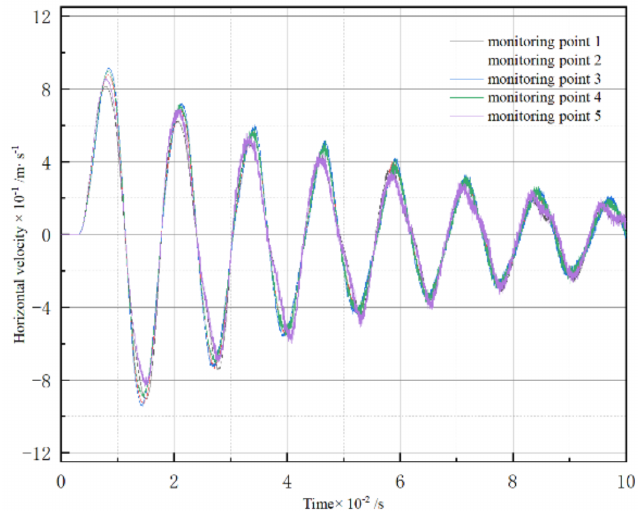
Figure 15. Monitoring curve of horizontal velocities (1).